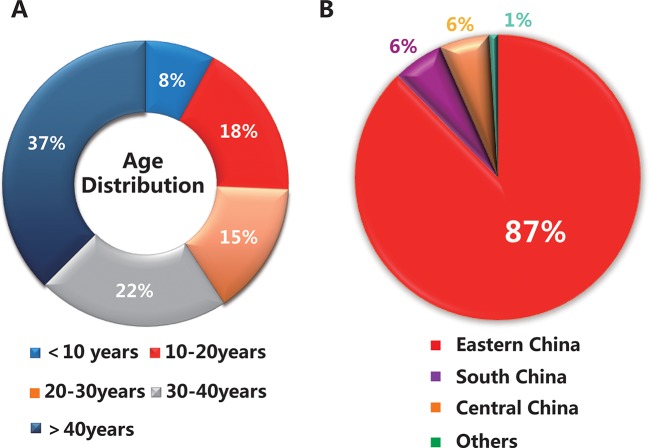
Basic information on the 153 subjects in this study. (A) The age distribution of the total cohort. (B) The geographical distribution of the population.